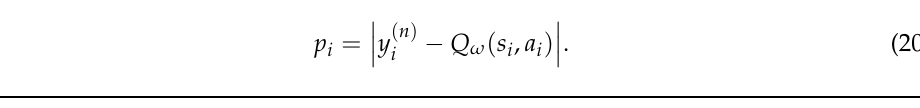
Algorithm 1 : SumTree-based data extraction algorithm